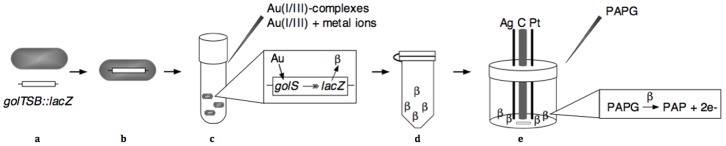
Schematic of methodology employed to build the Au biosensor.(a) The golTSB regulon is regulated by Au ions in Salmonella enterica serovar typhimurium. A synthetic golTSB regulon was made by fusing a promoter-less lacZ reporter gene downstream of the golB open reading frame as a transcriptional fusion. (b) This golTSB::lacZ transcriptional fusion was introduced as a single copy into the chromosome of E. coli. (c) A single clone was taken for further studies and incubated overnight, used to inoculate new media, then metals (various concentrations of Au(I) or Au(III) or cross reactivity testing with Cu(II), Ag(I), Fe(III), Ni(II), Co(II), Zn(II), As(III), Pb(II), Sb(III) and Bi(III) and Au(I) or Au(III)) were added and this was incubated for 16 h. (d) Cells were permebabilized for access to the β-galactosidase produced by the lacZ gene in the presence of Au. (e) The permeabilized cells were transferred to the electrochemical cell, p-aminophenyl-β-D-galactopyranoside (PAPG) was added. The β-galactosidase cleaves PAPG to p-aminophenol (PAP), the PAP is then oxidized by the carbon electrode vs. Ag/AgCl giving off electrons (e-) and the slope of the current-time plots were used to determine β-galactosidase enzymatic activity.